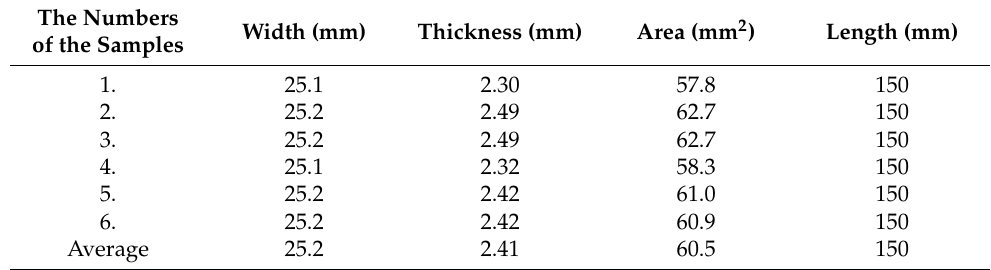
Table 4. Geometric dimensions of composite samples reinforced with the IMS65 CTLX biaxial fabric.